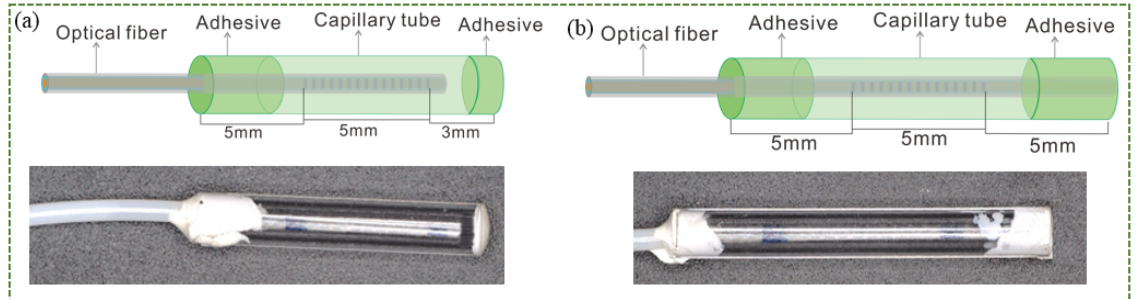
Figure 2. The structure of the sensors, ( a ) single-ended encapsulation, and ( b ) dual-ended encapsulation. In this study, a standard single mode optical fiber (Corning, SMF-28) was used for FBG fabrication. The fiber was loaded with hydrogen to render it photosensitive and striped